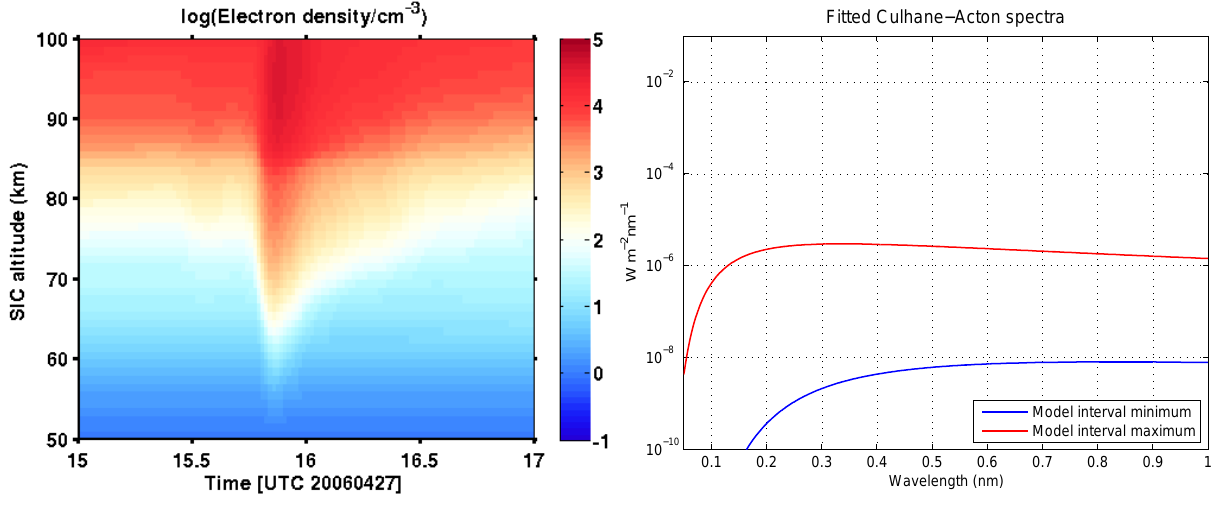
Fig. 8. GOES 10 measured X-ray irradiances for 27 April 2006. Left plot: The two GOES X-ray channels. Right plot: Fitted Culhane and Acton (1970) spectra for the maximum and minimum fluxes during the model run. Spectra fitted to 5-min average GOES data were used throughout the flare